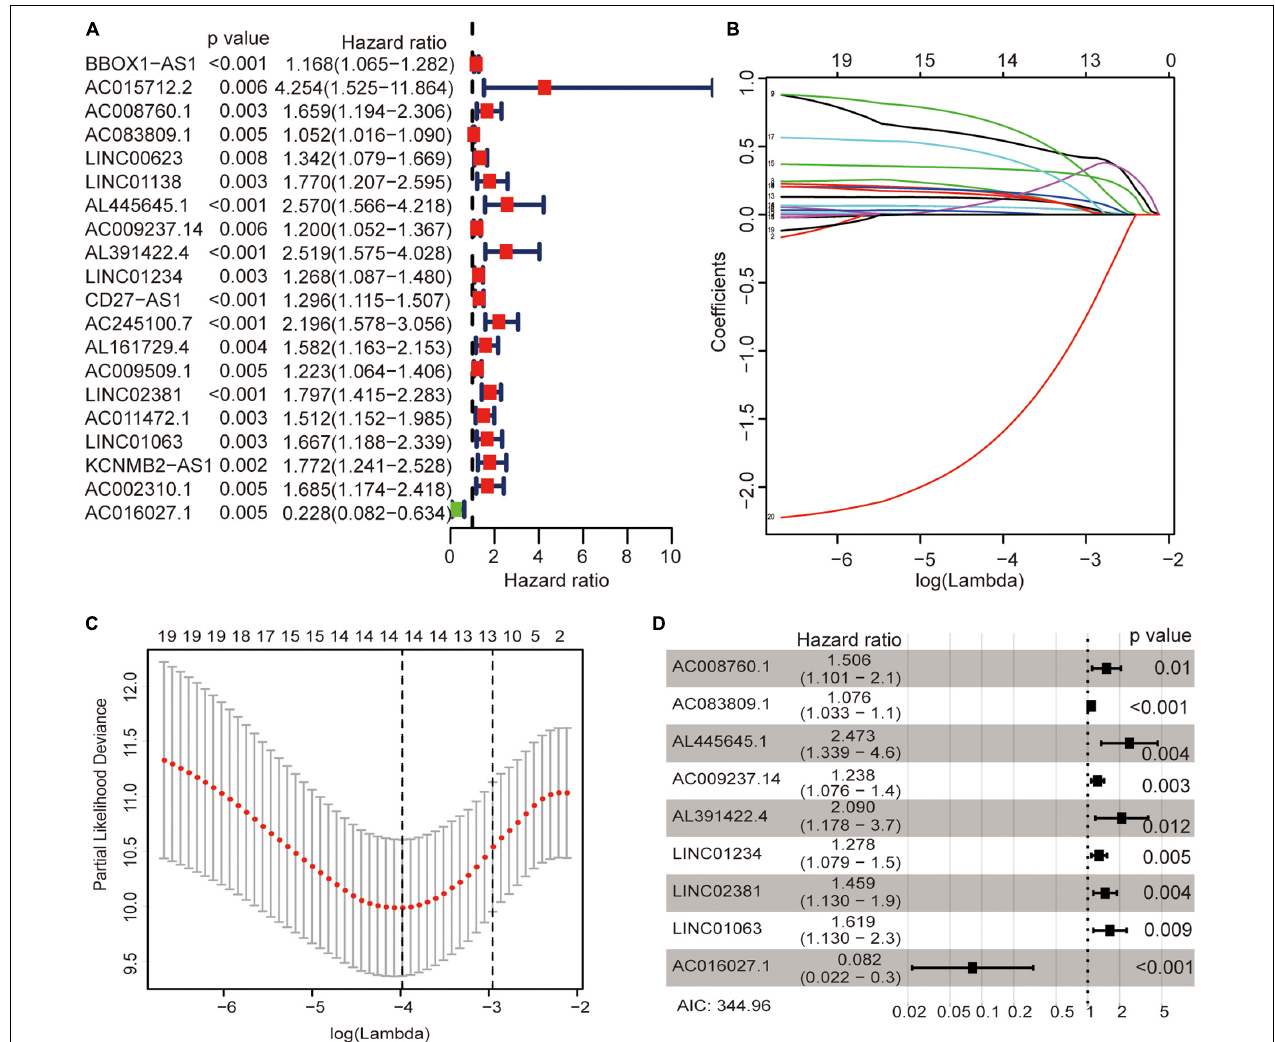
FIGURE 1 | Identification of immune-related lncRNAs associated with colon cancer prognosis. Univariate Cox regression models identified 20 immune-related lncRNAs associated with OS (A) . Fourteen immune-related lncRNAs were identified by a lasso regression analysis (B,C) . Nine immune-related lncRNAs were identified for the construction of a prognostic model by a multivariate Cox regression analysis (D) .